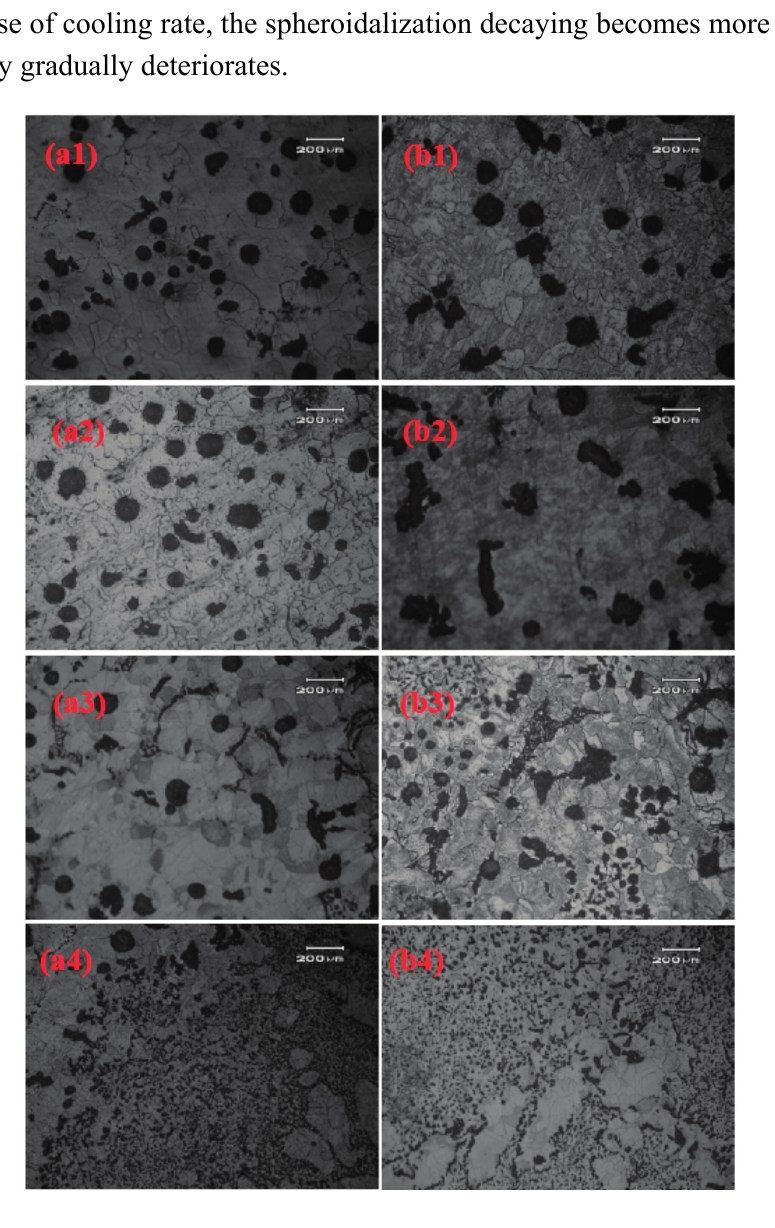
Figure 5. Graphite morphology of at four positions of two castings ( a1 ) specimen A1; ( a2 ) specimen A2; ( a3 ) specimen A3; ( a4 ) specimen A4; ( b1 ) specimen B1; ( b2 ) specimen B2; ( b3 ) specimen B3; and ( b4 ) specimen